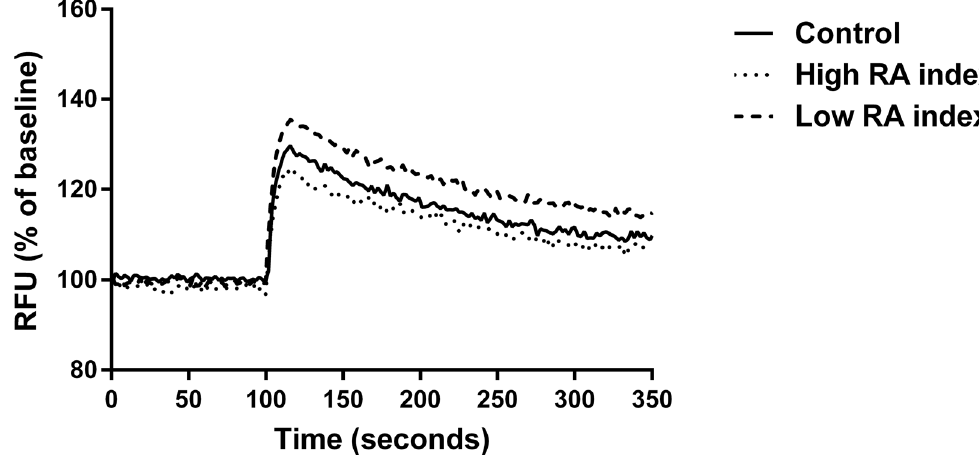
Fig 2. The effect of RA index on the plasma membrane potential. BRIN-BD11 cells were treated for 24 h with a control (no treatment), high RA index (20ng ml -1 resistin, 5nmol l -1 g-adiponectin) and a low RA index (10ng ml -1 resistin, 10nmol l -1 g-adiponectin). Cells were stimulated with 16.7mM glucose + 10mM alanine at 100 seconds. Data was analysed by determining the difference in relative fluorescence units (RFU) between the average baseline and post stimulation values for each experiment (delta change %). The increase in fluorescence (normalised to baseline) upon stimulation was 26.4% for control, 23.5% for high RA index and 33.9% for low RA index. Statistically significant differences exist upon the increase in RFU between control treatment and low RA index (p = 0.009) and high and low RA index (p = 0.003). Overall ANOVA p = 0.007. Values are represented as mean values (n =